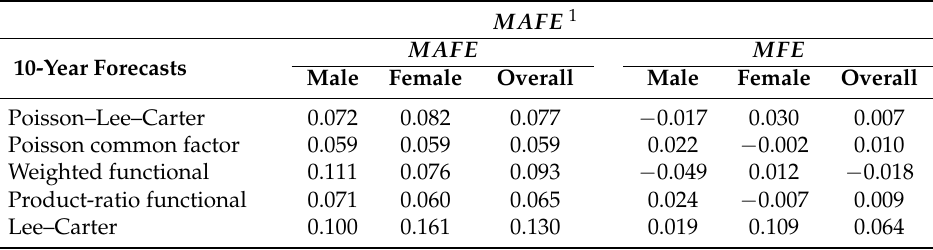
Table 6. Mean Absolute Forecast Error ( MAFE ) and Mean Forecast Error ( MFE ) of log death rates for males and females by method and gender for